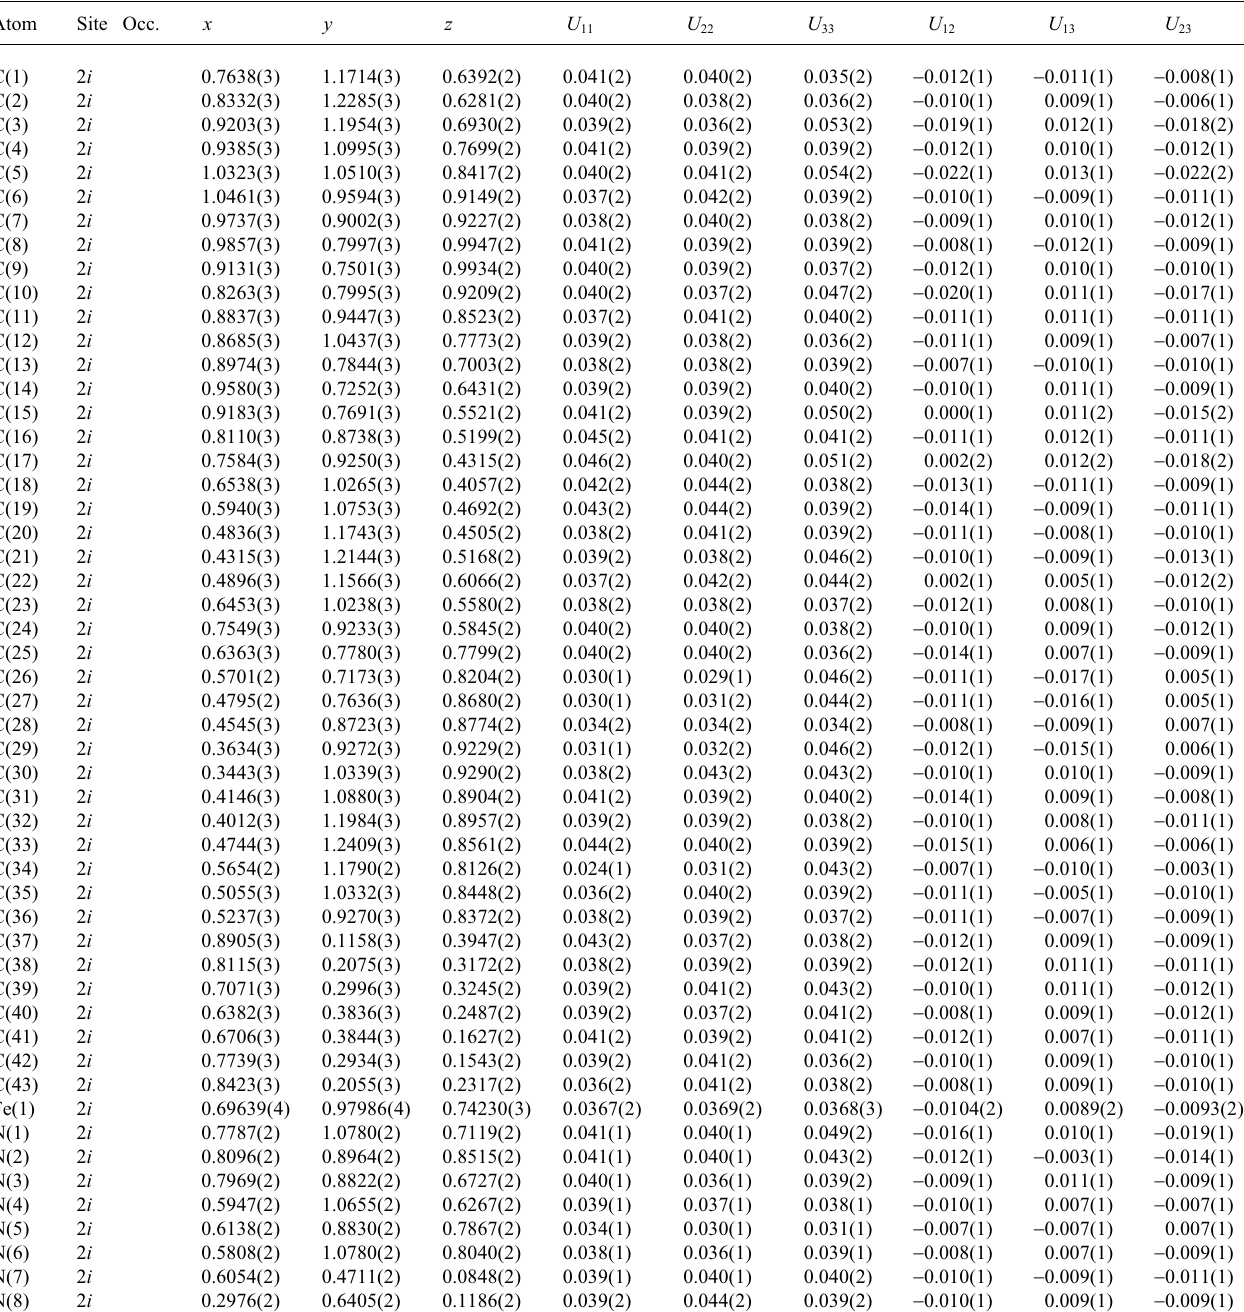
Table 3. Atomic coordinates and displacement parameters (in Å 2